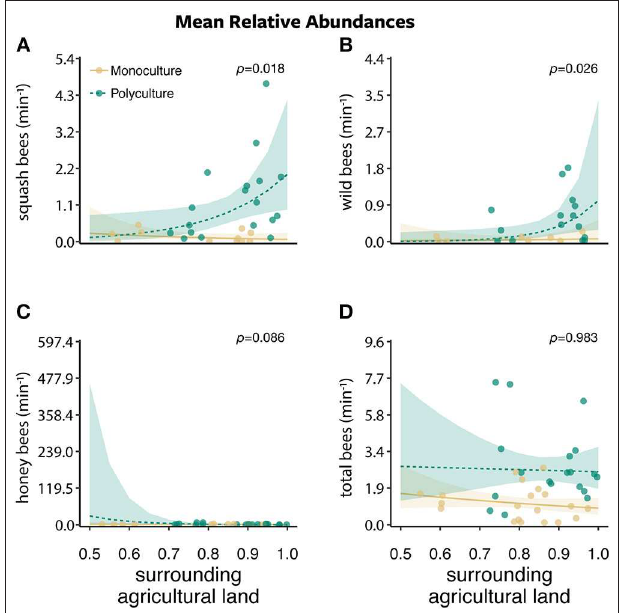
FIGURE 3 | The mean relative abundances ± standard error of (A) squash bees, (B) wild bees, (C) honey bees, and (D) total bees per minute along a 30m transect between two farm types (polyculture and monoculture) across the proportion of surrounding agricultural land.